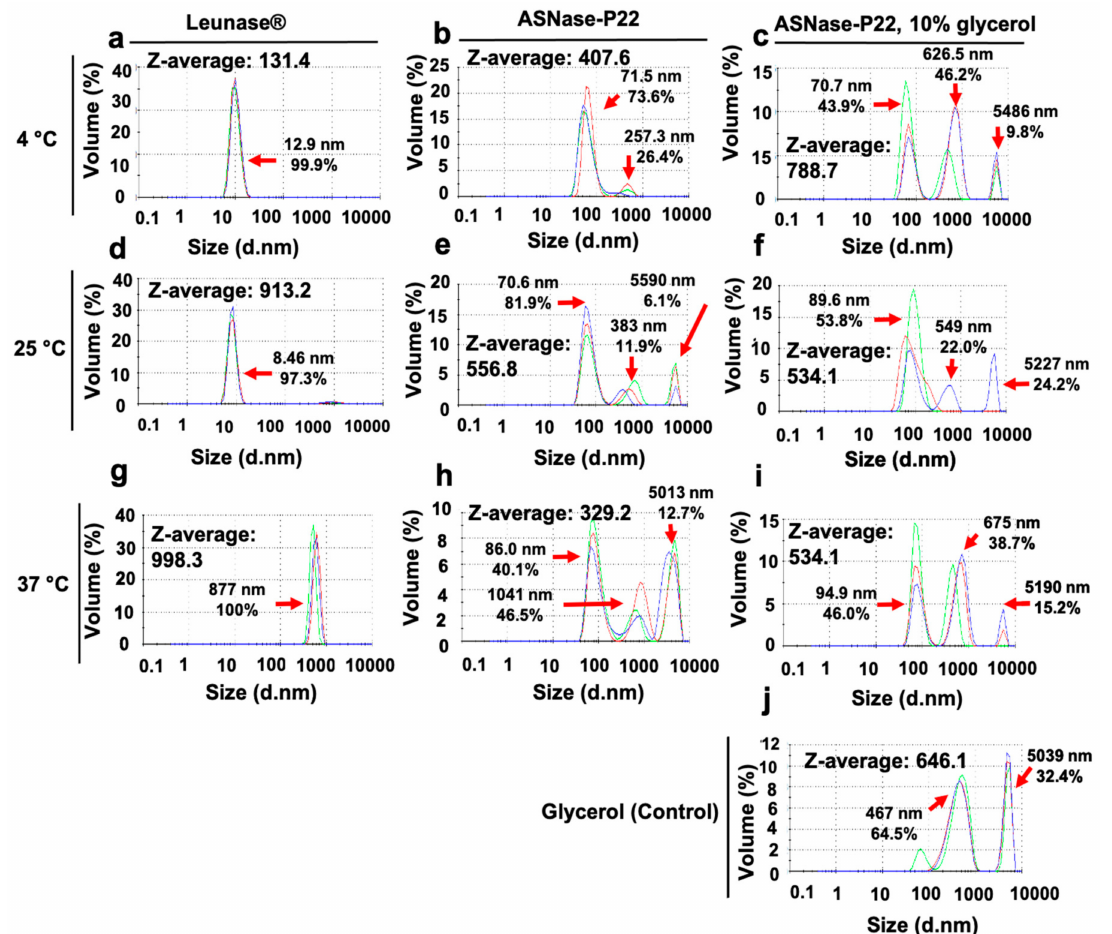
Figure 5. Dynamic light scattering (DLS) profile of ASNase-P22 nanoreactors incubated at 4, 25, and 37 ◦ C. ( a , d , g ) Leunase ® . ( b,e,h ) ASNase-P22, and ( c , f , i ) ASNase-P22 with 10% glycerol. ( j ) 10% glycerol in 50 mM PBS. Representative DLS profiles of at least n = 3 are shown. Z-averages, particle sizes (nm), and percentage of volume (mL) for each case are indicated in the